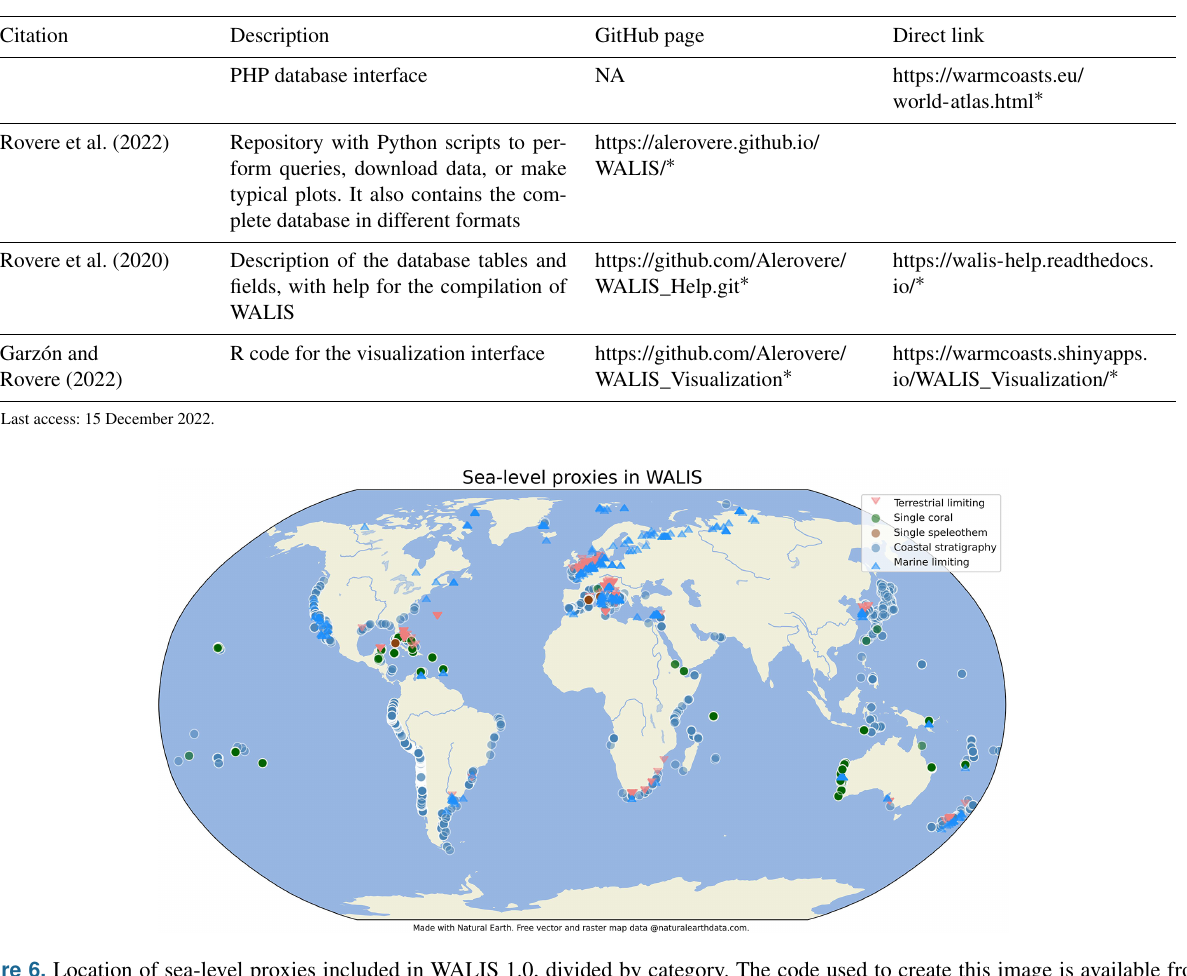
Table 1. Main resources associated with WALIS, with repositories on GitHub and the direct link to the application (if available). NA – not available.